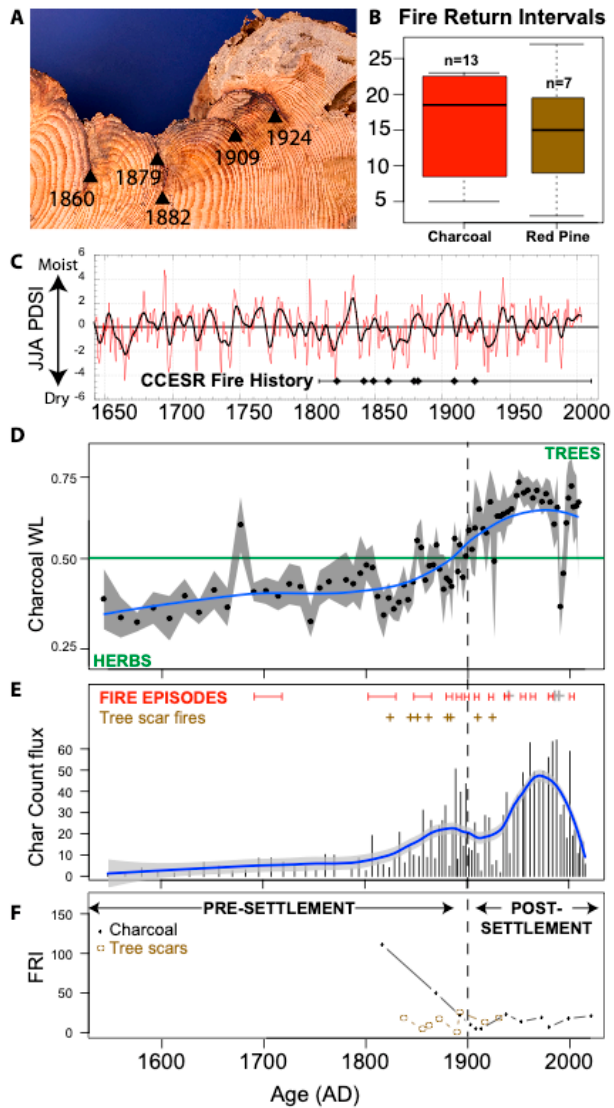
Figure 2. Fire history reconstructions. ( A ) Macrophotograph of growth rings from approximately 1852–2010 with fire scar events labeled. Each fire event occurred in the earlywood portion of the annual growth ring, suggesting late spring or early summer fires. ( B ) Box and whiskers plot illustrates distribution of intervals between tree-ring recorded fire episodes, with a median of 15 years for the active burning period (1822–1924 CE). Note that the recent 87-year hiatus in fire in the red pine stand (1925–2010 CE) is not included in this plot. ( C ) North American Drought Atlas tree-ring reconstructed Palmer Drought Severity Index (NADA PDSI) for southeastern Minnesota (NADA Gridpoint 45.25ºN, − 93.25ºE), with a time series of fire events (diamonds) recorded by a by the tree illustrated above. ( D ) WL ratio of each particle summarized by boxplot per sample. ( E ) Charcoal influx (# particles cm − 2 yr − 1 ) with a smooth spline LOWESS robust to outliers to identified significant peaks (above the 95% confidence interval about the spline) from the background. Significant peaks are noted with red intervals accounting for the date uncertainties. For fire episodes identified in two consecutive samples, only one fire episode was retained (not retained fire episodes are grey crosses). ( F ) Fire return interval calculated as the number of years between two fires, derived from the fire event dates for the two